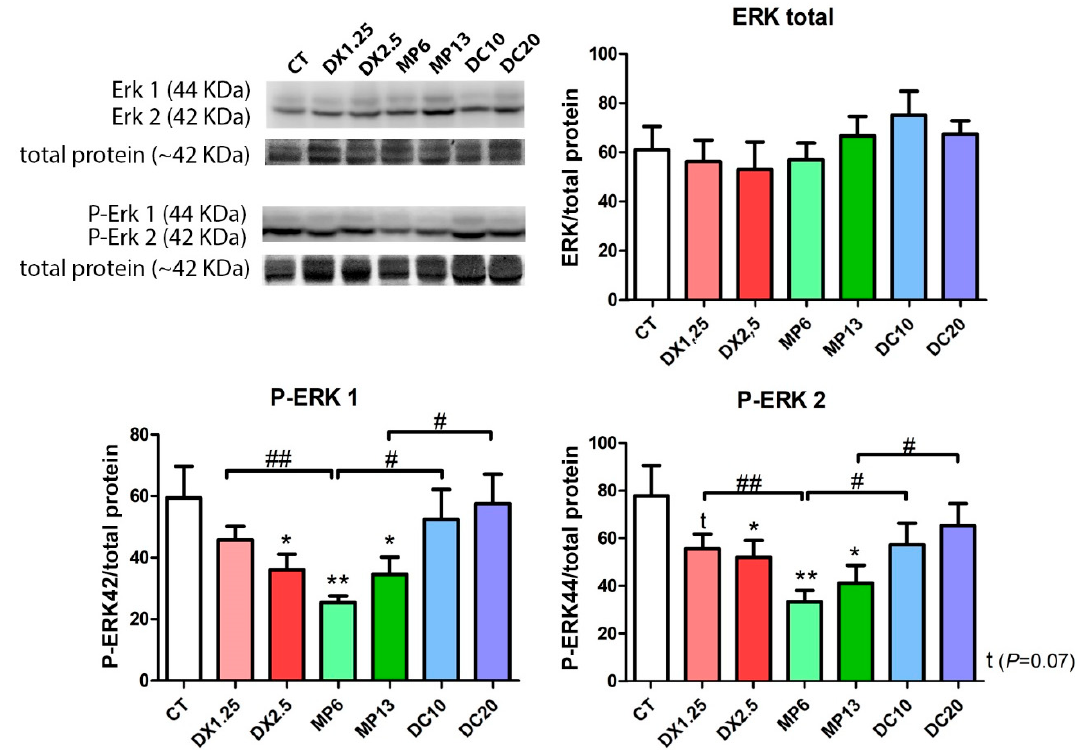
Figure 7. Western blotting analysis of the Ras / Raf / MEK / ERK pathway after the administration of different glucocorticoids. (*) represents the statistical difference in comparison to the CT and (#) represents statistical difference between groups. Legend: * or # = P < 0.05; ** or ## = P < 0.01 (n per group: CT = 10, DX1.25 = 9, DX2.5 = 8, DC10 = 10, DC20 = 10, MP13 = 8, MP6 = 8).